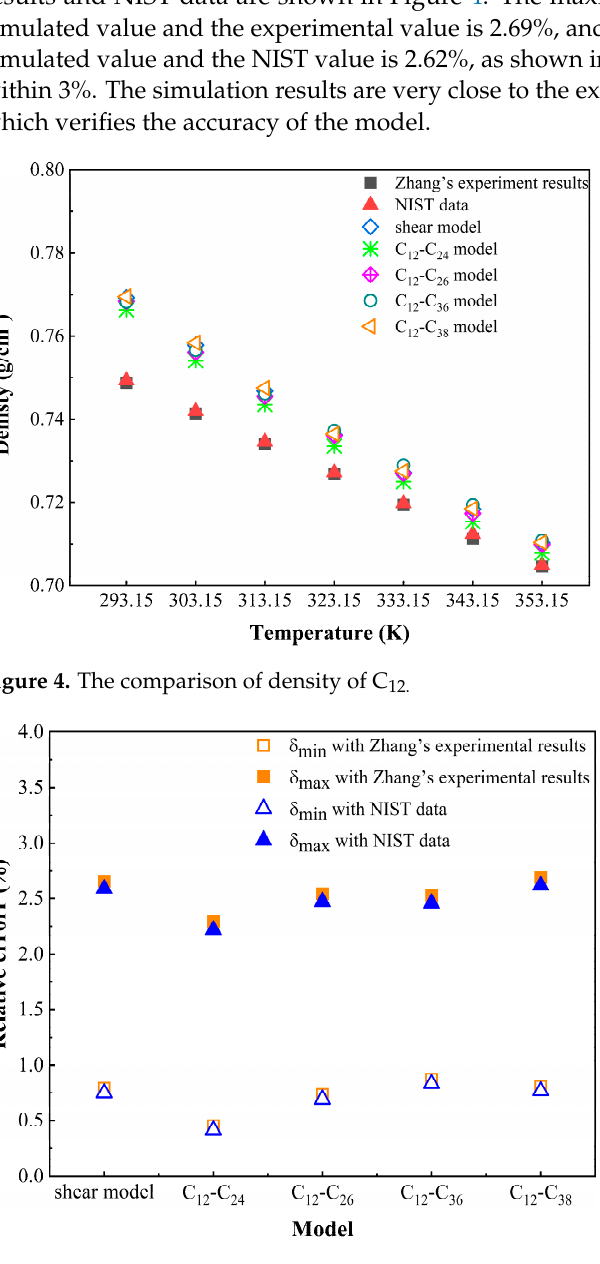
Figure 5. Relative error of density.